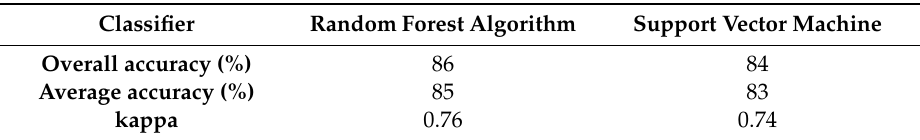
Table 3. Comparison of the accuracy of the classifiers.